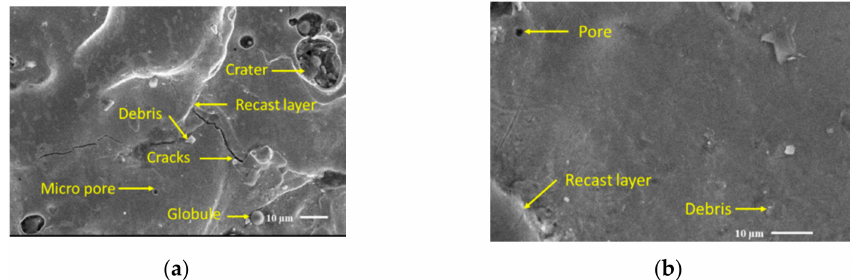
Figure 14. Variation of surface morphology with P (I p , V g , T on , T off , P) ( a ) (7, 60, 300, 30, 13); ( b ) (7, 60, 300, 30, 19); units as per Table